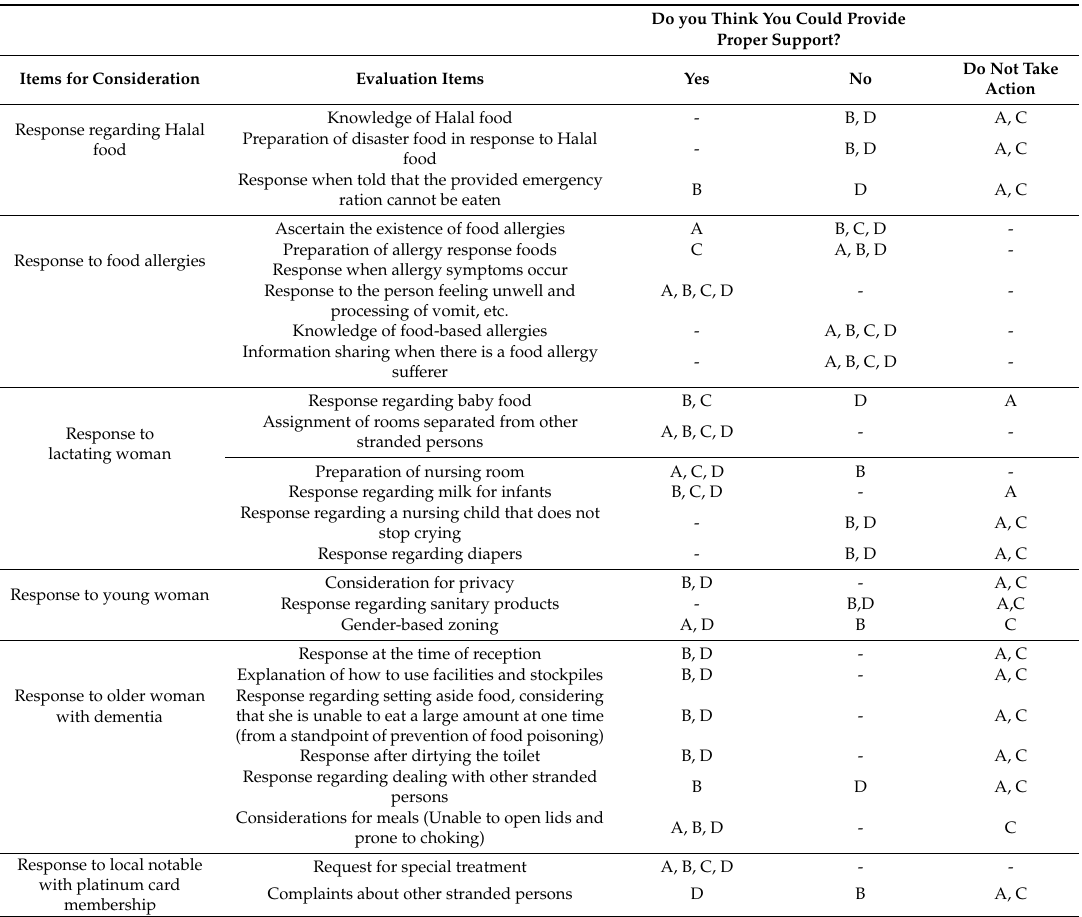
Table 5. Self-evaluation about response to vulnerable people by those in acceptance roles (n = 4, facility sta ff members shown as A, B, C, and